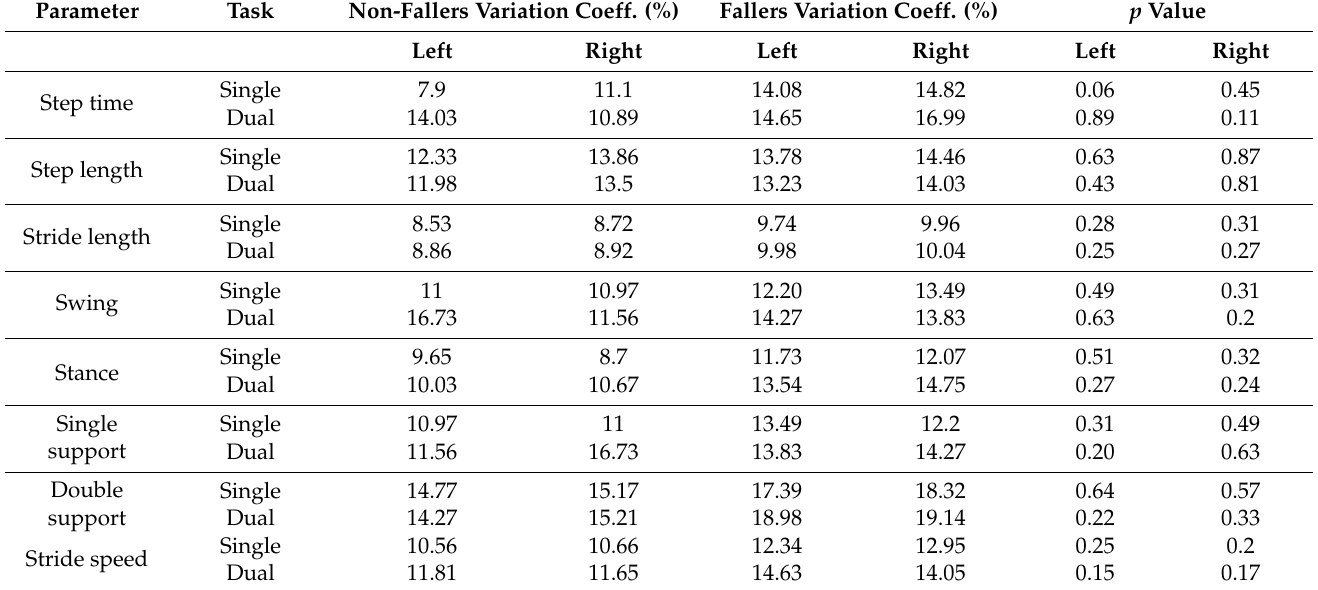
Table 4. Variability of gait parameters between fallers and